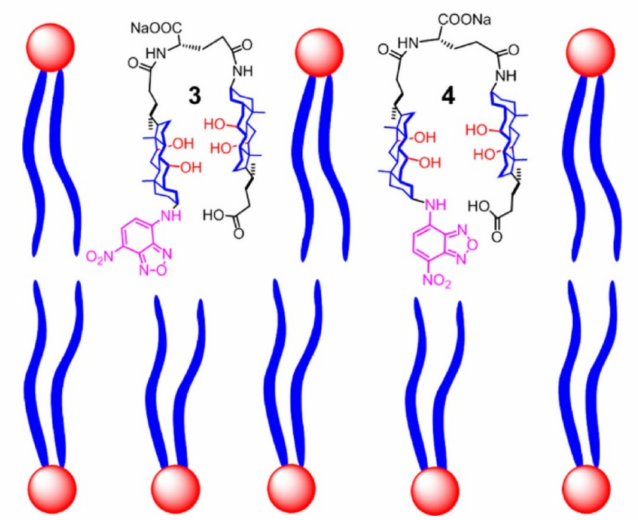
Figure 14. Schematic representation of possible conformations of the foldamer 3 and 4 in the lipid bilayer. The fact that 3 emitted at a significantly lower wavelength than 4 suggests that the former was located in a more hydrophobic microenvironment than the latter. Reprinted with permission from reference [218]. Copyright 2015 American Chemical